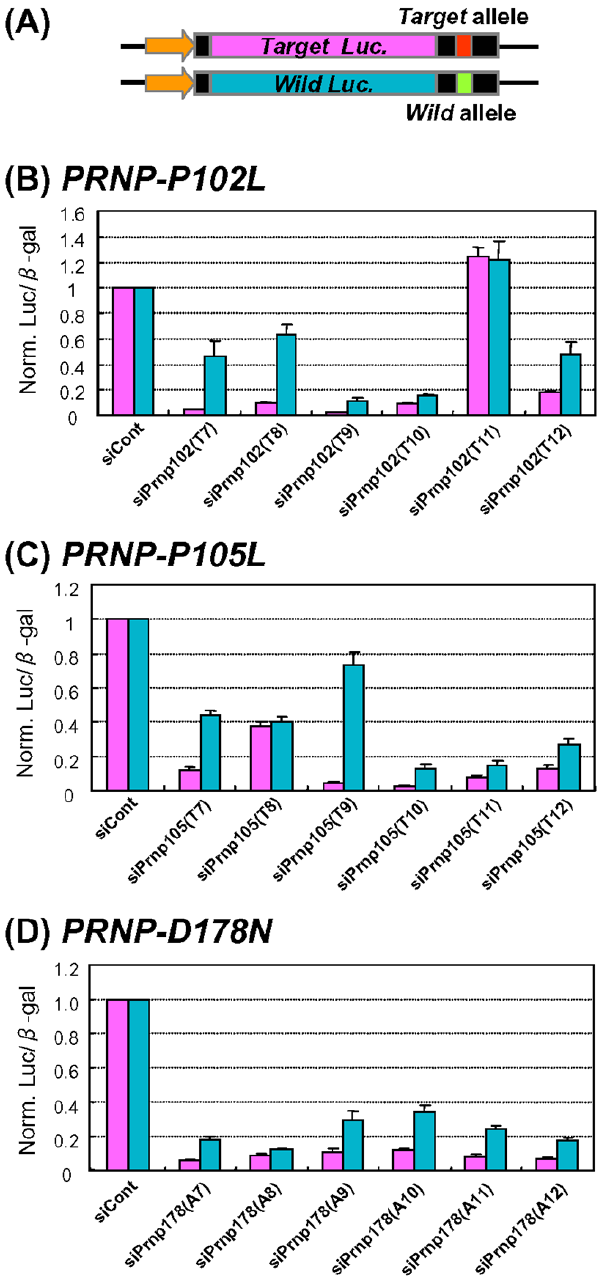
Figure 1. Assessment of ASP-RNAi with reporter alleles . (A) Schematic drawing of reporter alleles. Reporter alleles were constructed by inserting synthetic oligonucleotides of mutant and wild-type allelic sequences into the 3 9 -UTRs of the reporter genes driven by the same TK promoter (indicated by arrows). Assessment of designed siRNA duplexes against the mutant allele was carried out as described in Materials and Methods. Effects of designed siRNA duplexes against the PRNP-P102L (B), PRNP -P105L (C), and PRNP -D178N (D) mutants on ASP-RNAi. Reporter alleles,synthetic siRNA duplexesagainst the mutantalleles(indicated) and the b -galactosidase gene (control) were cotransfected into HeLa cells. Twenty-four hours after transfection, expression levels of the reporter genes were examined. Levels of either mutant allele (pink boxes) or wild- type allele (blue boxes) luciferase activity were normalized against the levels of b -galactosidase activity, and the ratios of mutant and wild-type luciferase activities in the presence of siRNA duplexes were normalized against the control ratios obtained in the presence of siControl duplex (siCont). Data are averages of at least three independent determinations. Error bars represent standard